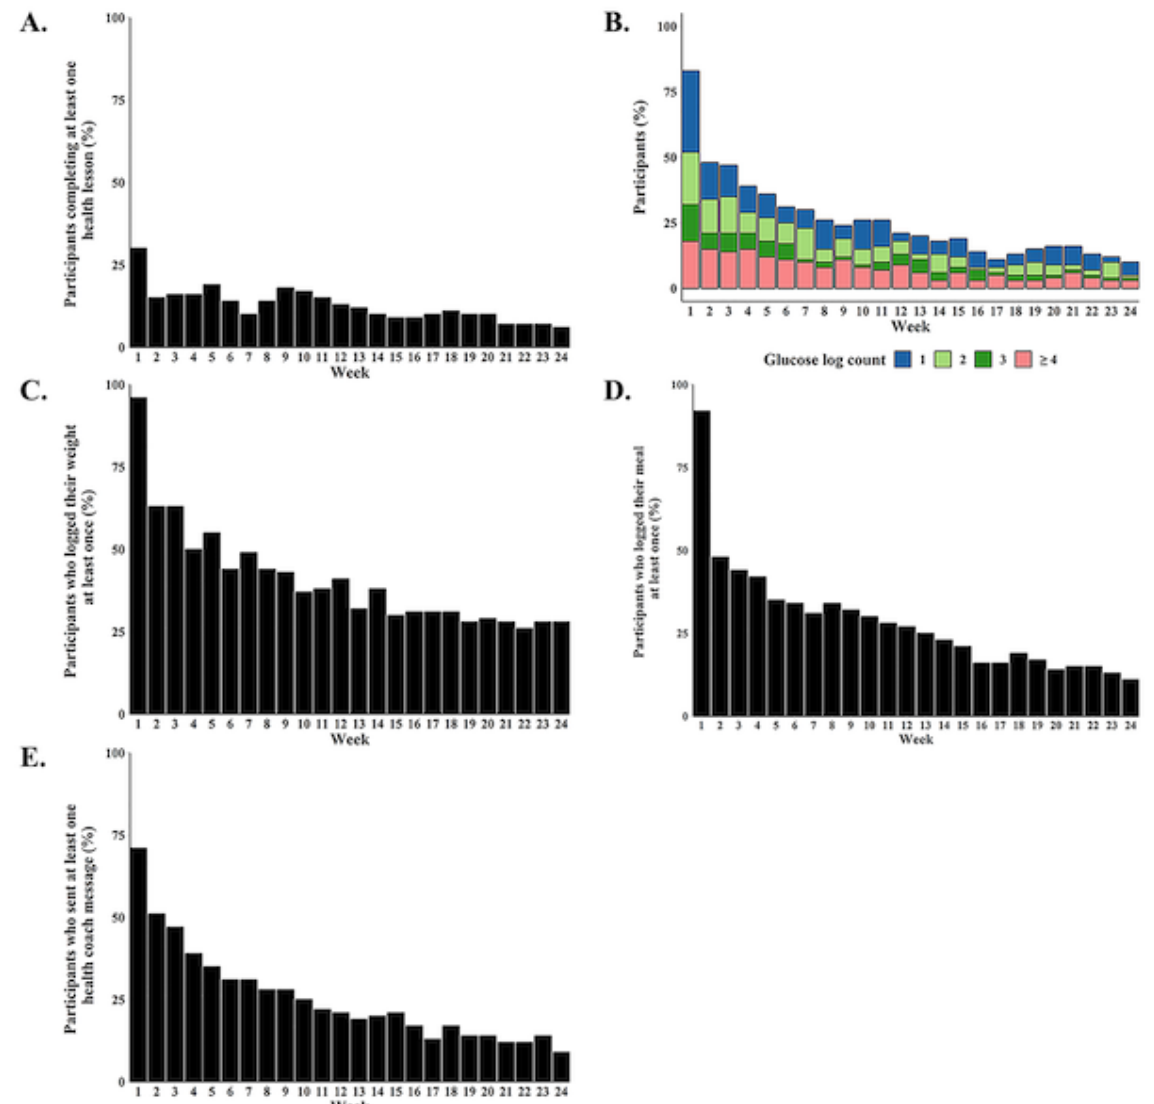
Figure 2. Proportion of program engagement by week for the total sample (n=100). Percentage of participants who (A) completed at least one lesson, (B) logged 1, 2, 3, or ≥ 4 glucose measurements, (C) logged at least one weight log, (D) logged at least one meal log, or (E) sent at least one message to their health coach a